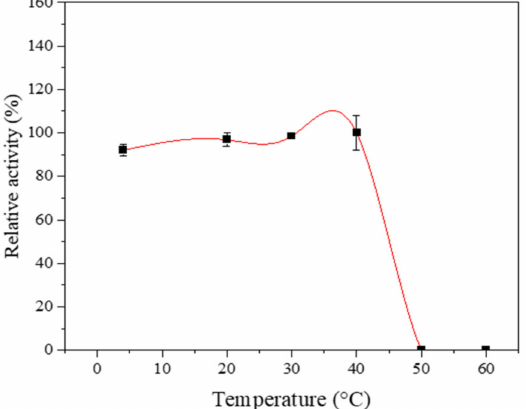
Figure 2. Thermostability analysis of BAMF2522. The enzyme (1.2 µ M) was preincubated for 60 min at the indicated temperatures (4 ◦ C, 20 ◦ C, 30 ◦ C, 40 ◦ C, 50 ◦ C, 60 ◦ C and 70 ◦ C) before measuring the residual enzyme activity at 30 ◦ C for a period of 20 min with 400 rpm shaking. No activity was observed at 50 ◦ C, 60 ◦ C and 70 ◦ C. The assays were carried out in 50 mM Tris-HCl, pH 7.5 and 5% ethanol, with 0.6 mM of C15:0 substrate and 0.2 mM NADPH. Numerical data with errors are given in Table